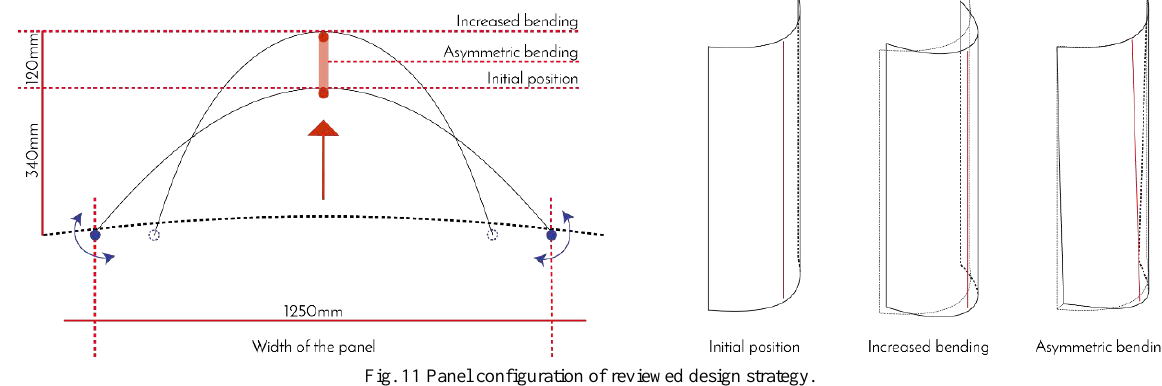
Fig. 11 Panel configuration of reviewed design strategy.